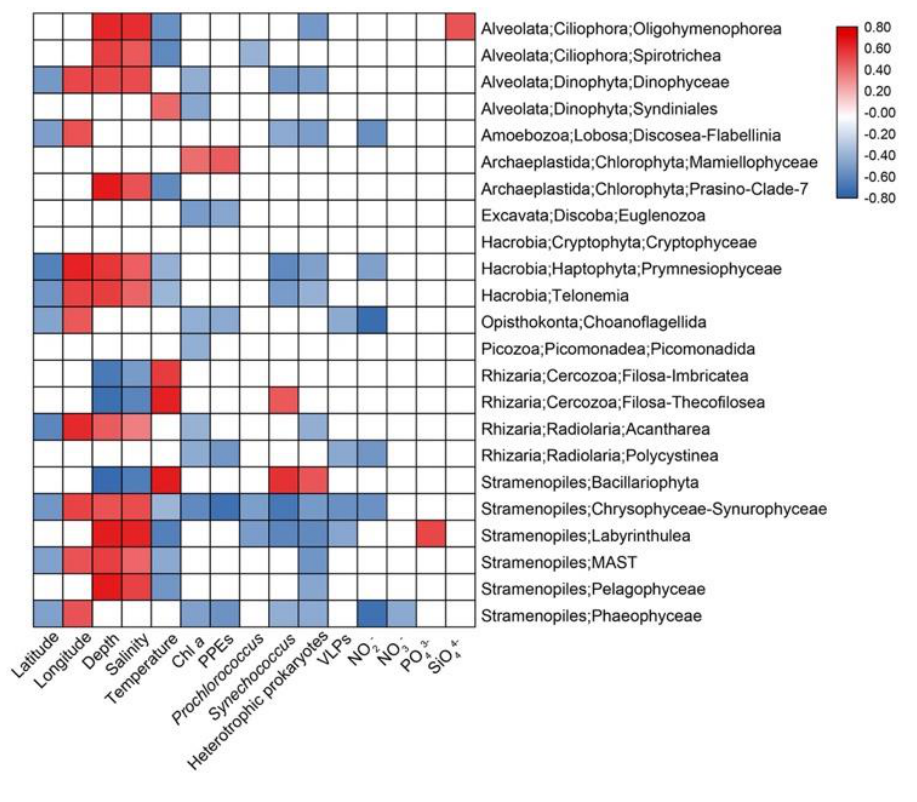
Figure 7. Spearman’s correlations between relative sequence abundance of major protistan groups and environmental parameters. The correlation coefficients’ values are indicated according to the color bar and insignificant values ( p > 0.05) are left blank.